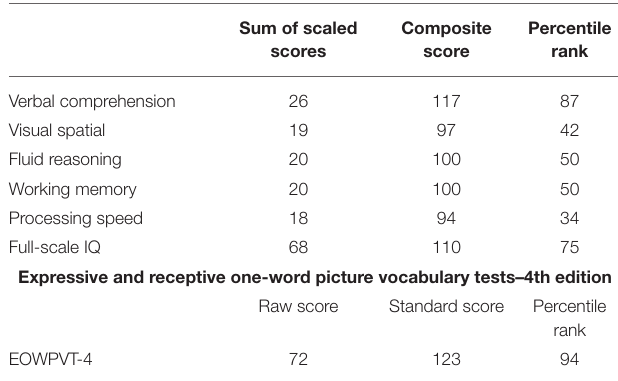
TABLE 2 | MF neurodevelopmental